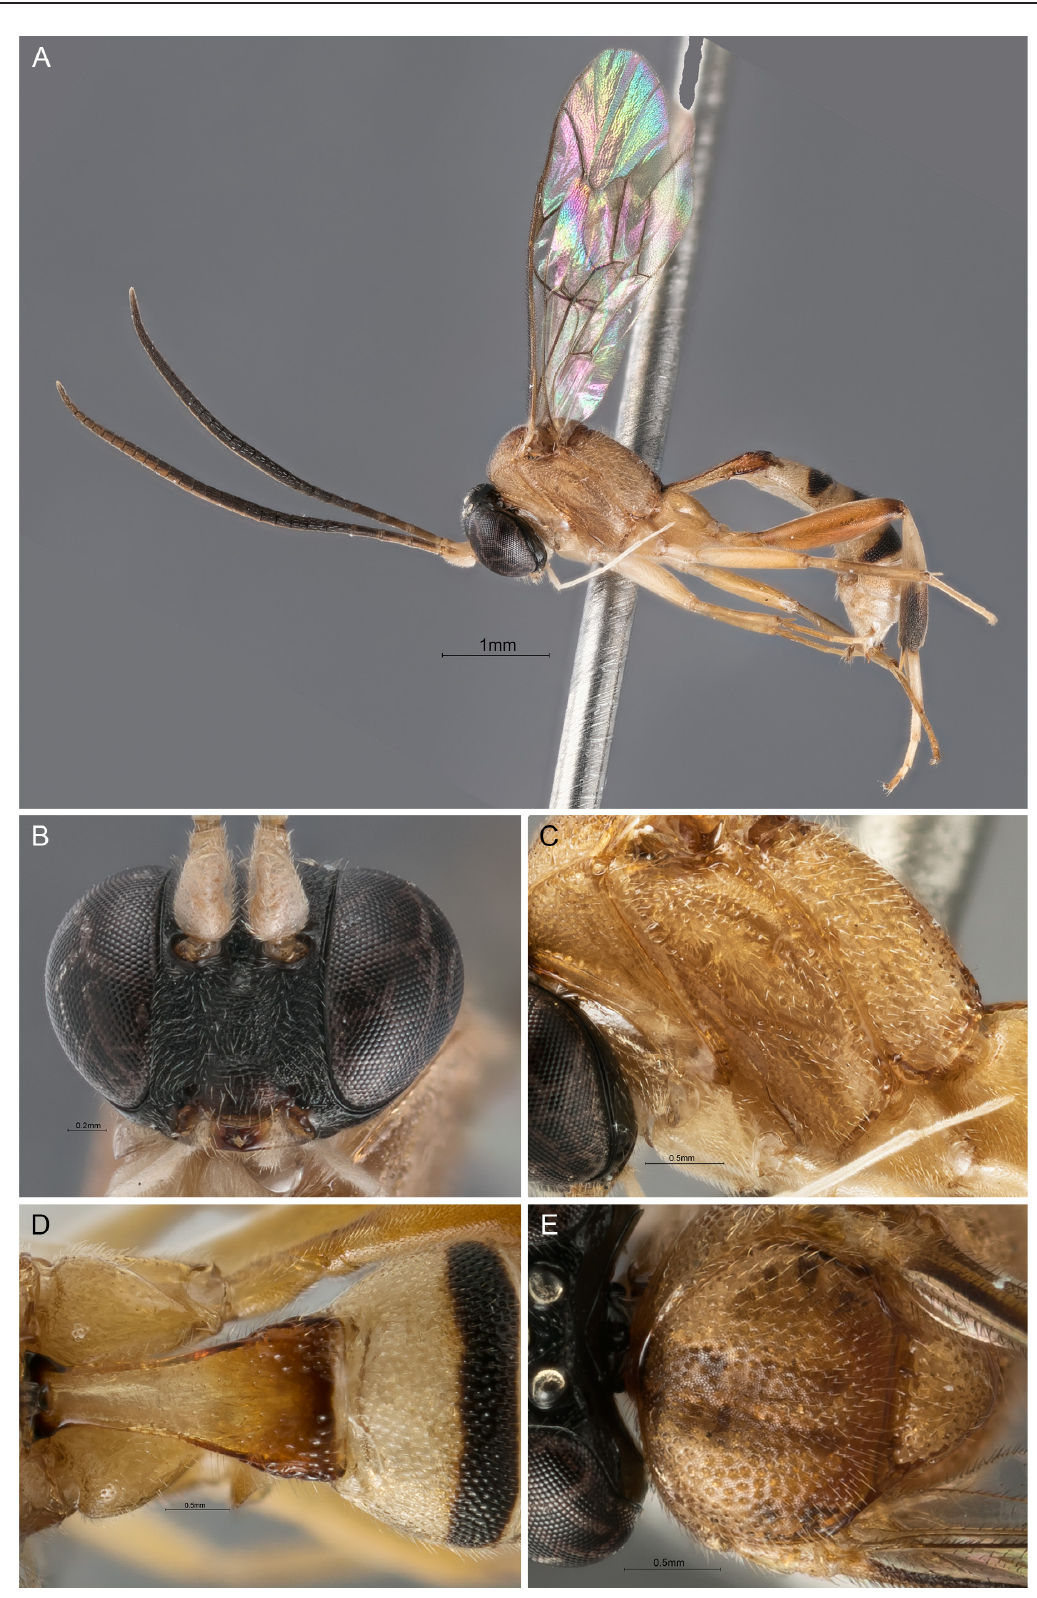
Fig. 26. Palpostilpnus singaporensis sp. nov., holotype, ♀ (LKCNHM). A . Lateral habitus. B . Head, anterior view. C . Mesopleuron. D . T1, dorsal view. E .